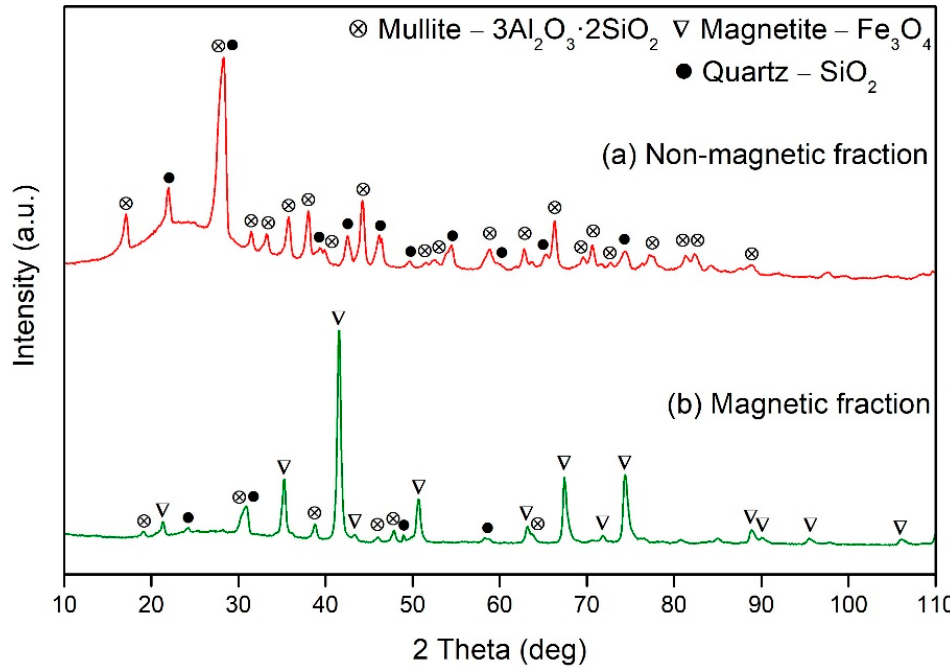
Figure 5. XRD patterns of the non-magnetic ( a ) and magnetic ( b ) fractions of CFA after wet magnetic separation at 0.11 T.